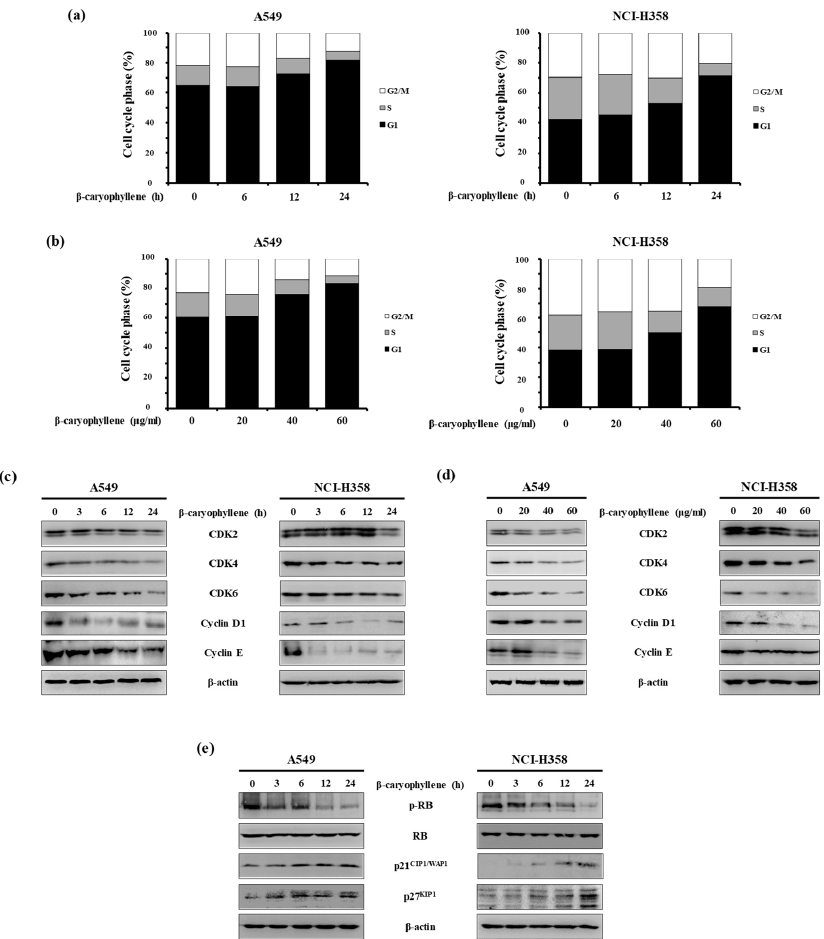
Figure 4. Effect of β -caryophyllene on G1 cell cycle arrest and cell cycle-related proteins in human lung cancer. ( a ) Cells were treated with β -caryophyllene (A549, 40 µ g / mL; NCI-H358, 60 µ g / mL) for the indicated times; ( b ) or with the indicated concentrations for 24 h. Cells were stained with PI for 30 min and then subjected to flow cytometry analysis to determine cell cycle progression. ( c and d ) A549 and NCI-H358 cells were treated with β -caryophyllene (A549, 40 µ g / mL; NCI-H358, 60 µ g / mL) for the indicated times and concentrations, and cells were collected for western blot analysis to measure cyclin / CDK protein expression. ( e ) Cells were treated with β -caryophyllene (A549, 40 µ g / mL; NCI-H358, 60 µ g / mL) for the indicated times, and then subjected to western blot analysis to determine the protein expression of p-RB, RB, p21 CIP1 / WAP1 , and p27 KIP1